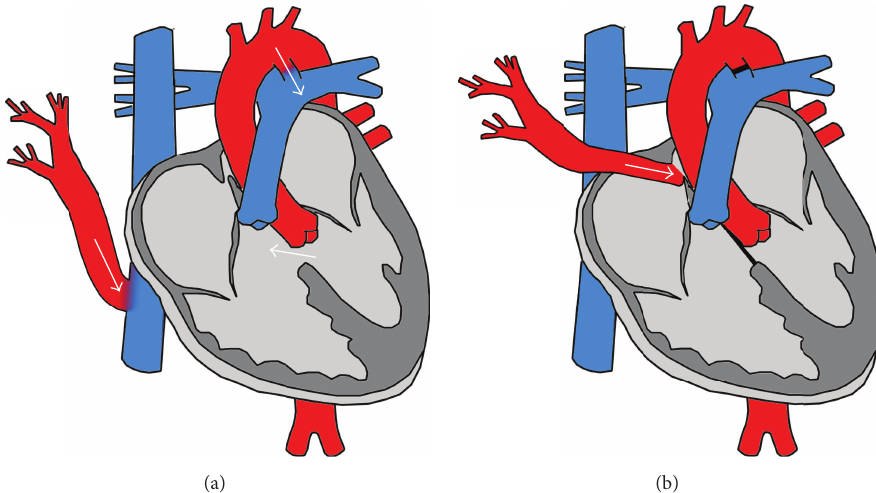
Figure 1: Schematic representation of preoperative situation (a) and after surgery (b). Surgical repair of the scimitar anomaly included redirection of the lung veins via patch into the left atrium, closure of the ventricular septal defect, and ligature of the ductus